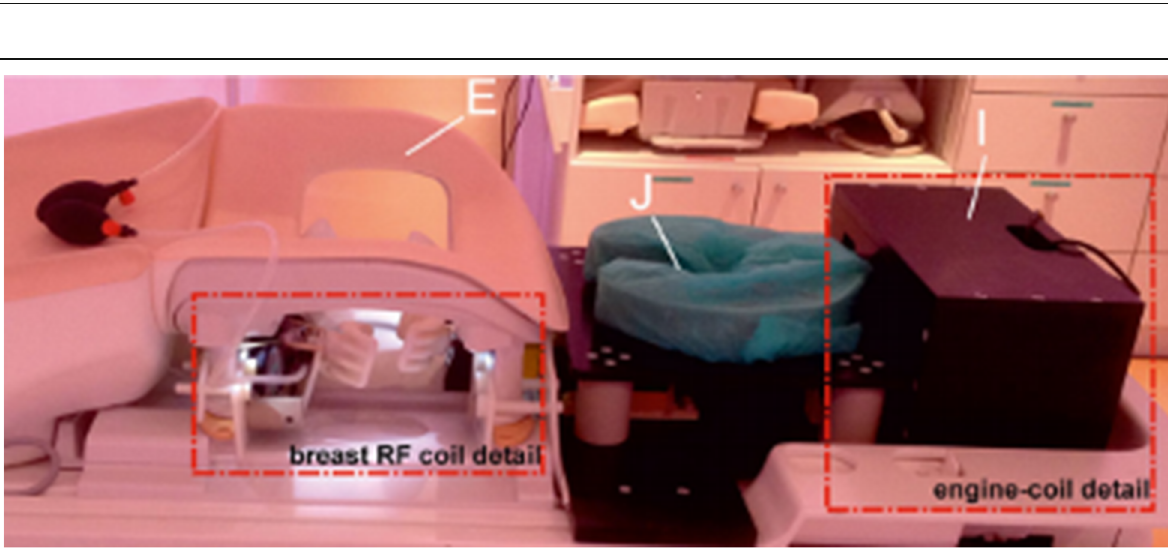
Fig. 15 An overview of MRE equipment including RF coil (left) and engine coil (right)